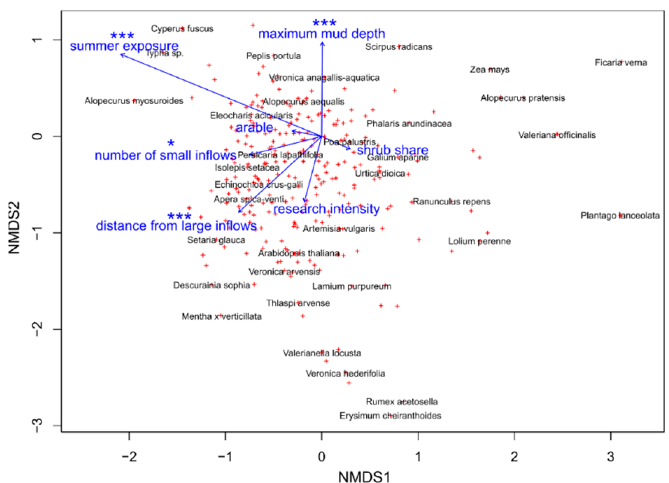
Figure 6. NMDS ordination diagram of species composition of vascular plant and charophyte as- semblages of the Dehtá ř fishpond with passively projected selected environmental and manage- ment factors. Significant relationship of the factors to species composition is indicated based on 999 per- mutations. ***—highly significant ( p ≤ 0.001), *—weakly significant ( p ≤ 0.05). The correlations were calculated using the envfit function from the vegan package (Oksanen [93]). Explanations of abbreviated names of the selected factors: summer exposure (=extent of bottom exposure in sum- mer), research intensity (=number of visits in the given segment and year), shrub share (% share of shrubs in the buffer zone between open water and the surrounding landscape), arable (=surrounding landscape with prevailing arable land). For more detail, see Table